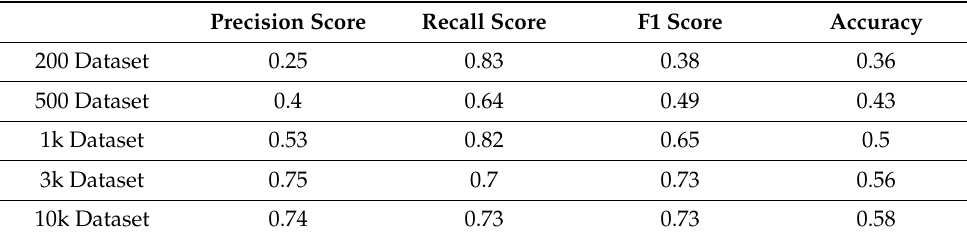
Table 5. Results of the SVM.